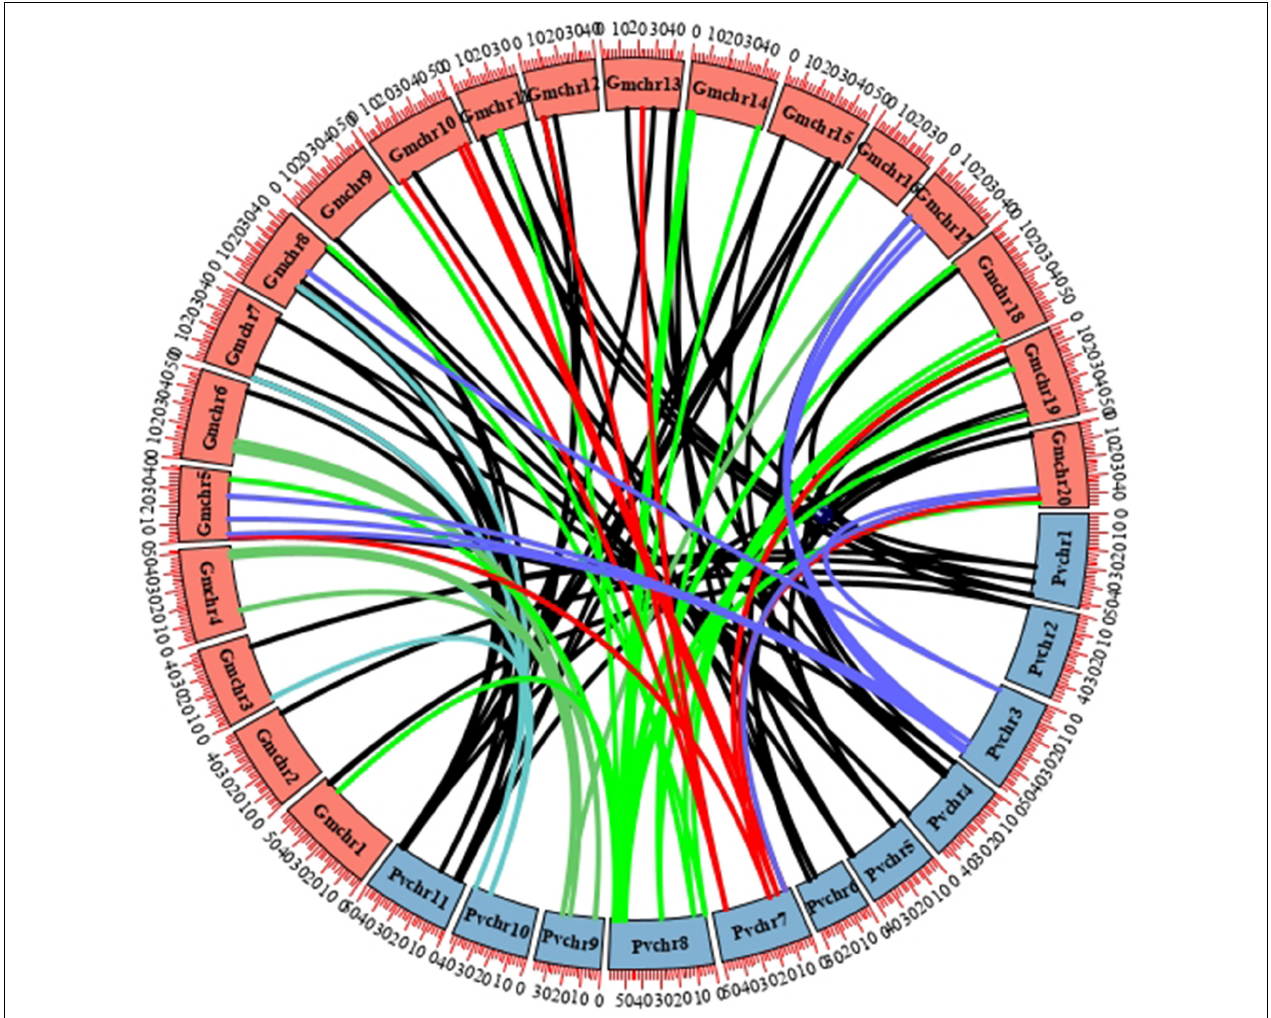
FIGURE 3 | Synteny analysis of LBD genes in soybean and common bean. Circular collinearity analysis of LBD genes in soybean and common bean genomes. GmLBDs and PvLBDs were mapped to their corresponding chromosomal locations and represented in a circular diagram using Circos. Colored lines connect the pairs of orthologous LBD genes in the syntenic blocks of these two genomes. Soybean and common bean chromosomes are denoted as red and blue boxes,